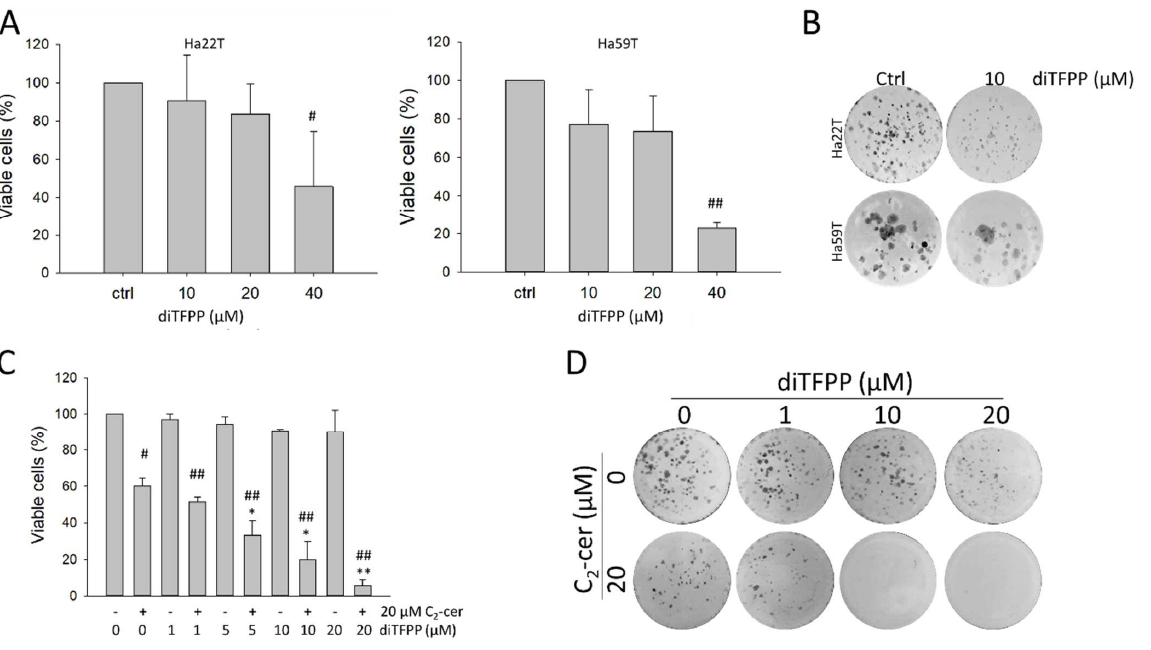
Figure 1. Effect of diTFPP/C 2 -ceramide cotreatment on the proliferation and viability of HCC cells.